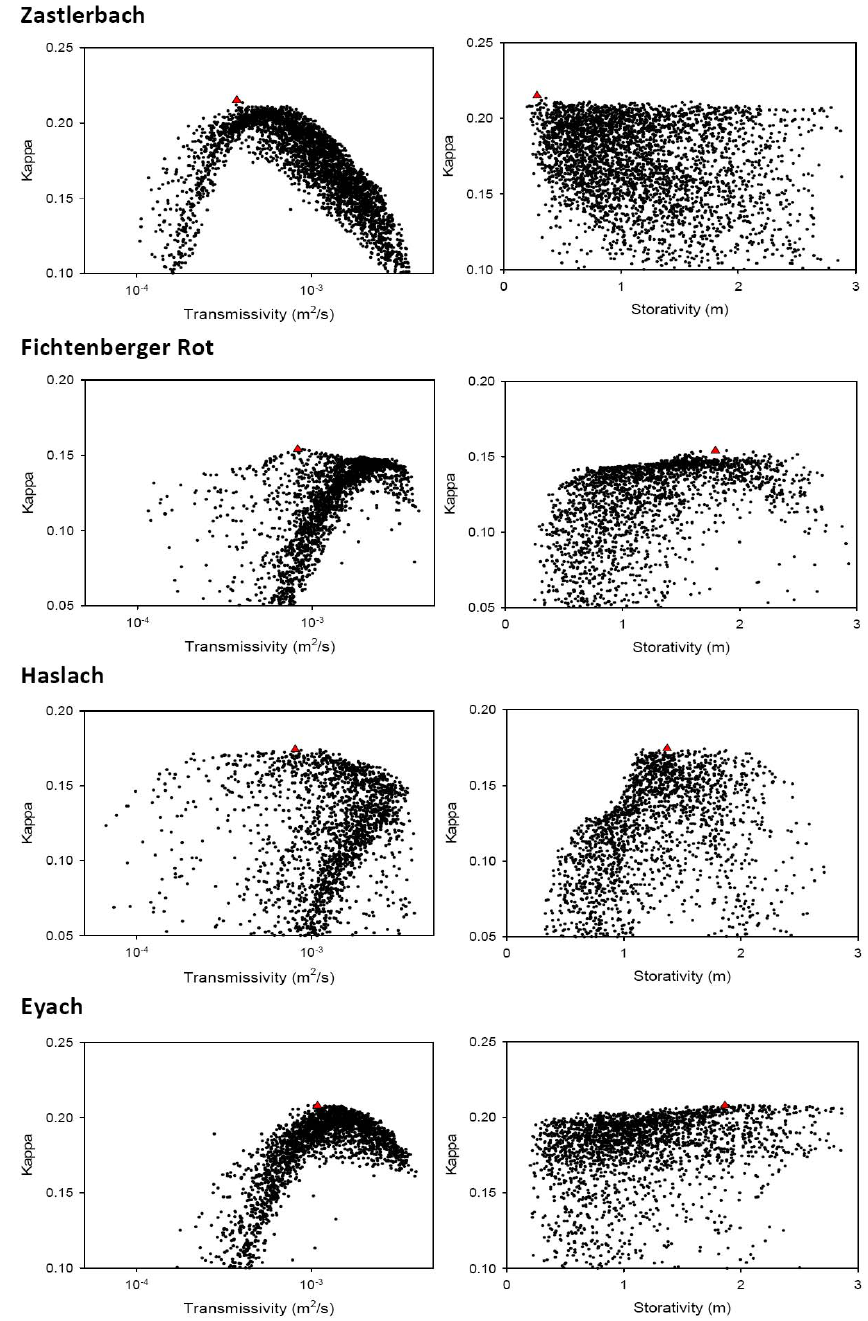
Fig. 2. Dotty plots of transmissivity and storativity. Figure 2. Dotty plots of transmissivity and storativity. 3 decline however, the behaviour is not as distinct. Contrary to variations of the two parameters affecting the